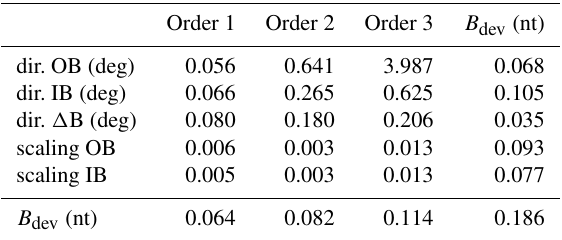
the correction of FGMI data using FGMO measurements, together with the corresponding maximum deviation of the corrected mag- netic field. Order 1 Order 2 Order 3 B dev